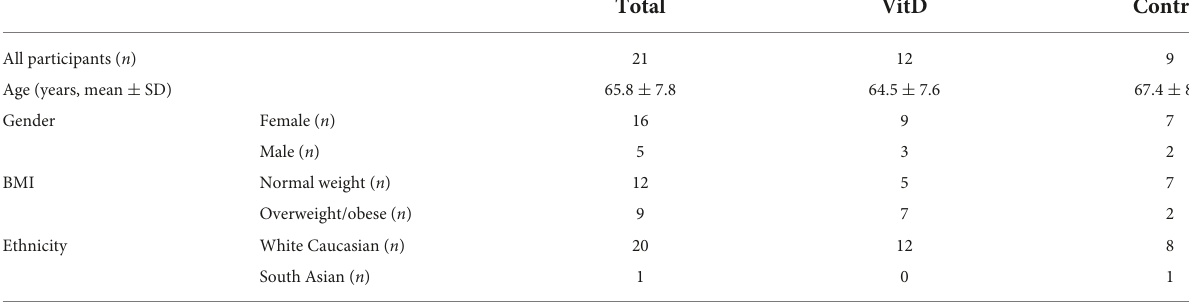
TABLE 1 Characteristics of the